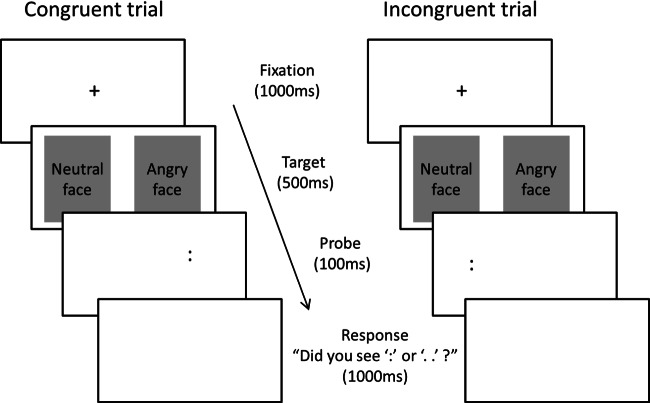
Dot-probe task parameters.The original stimuli, not displayed here due to copyright reasons, were grey-scale faces taken from the NimStim dataset (Tottenham et al., 2009).